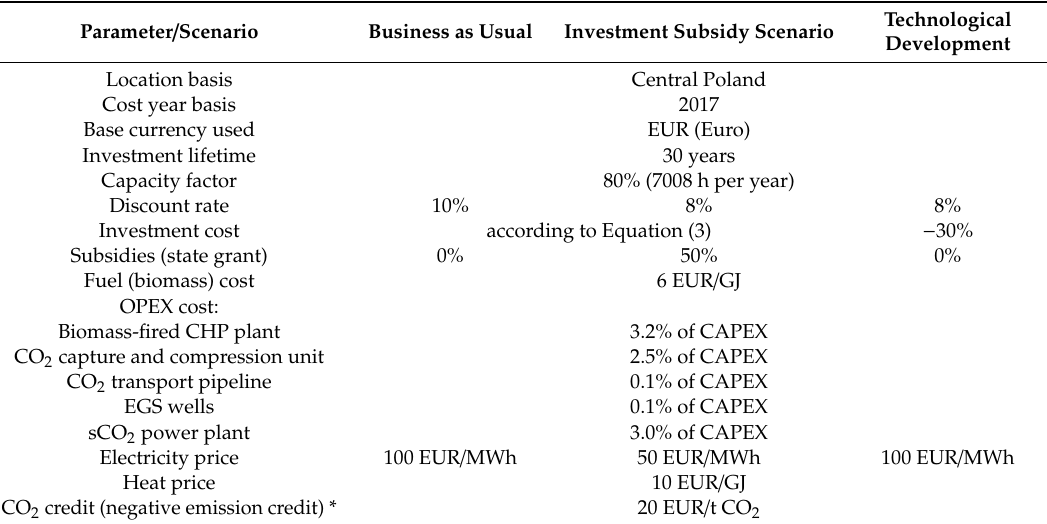
Table 5. Summary of financial